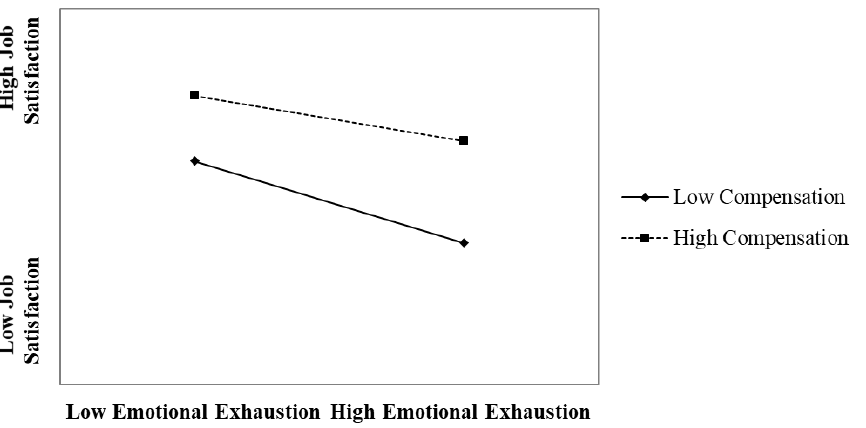
Figure 3. The moderating effect of compensation on the relationship between emotional exhaustion and job satisfaction.